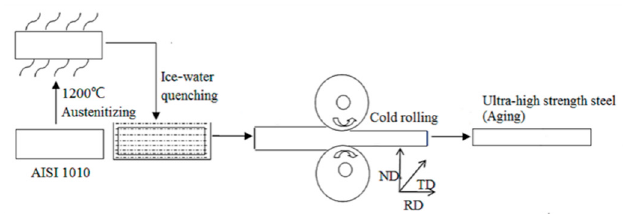
Figure 1. Preparation process of ultra-high strength low carbon steel.